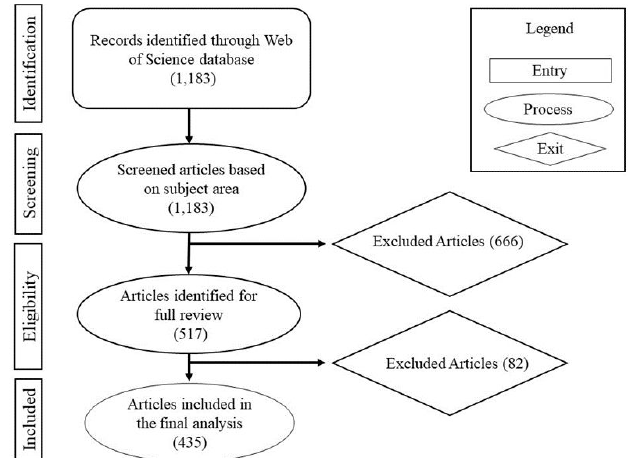
Figure 1. Summary of systematic review steps. PRISMA flow diagram (Moher et al., 2009) summarizing the study inclusion and exclusion